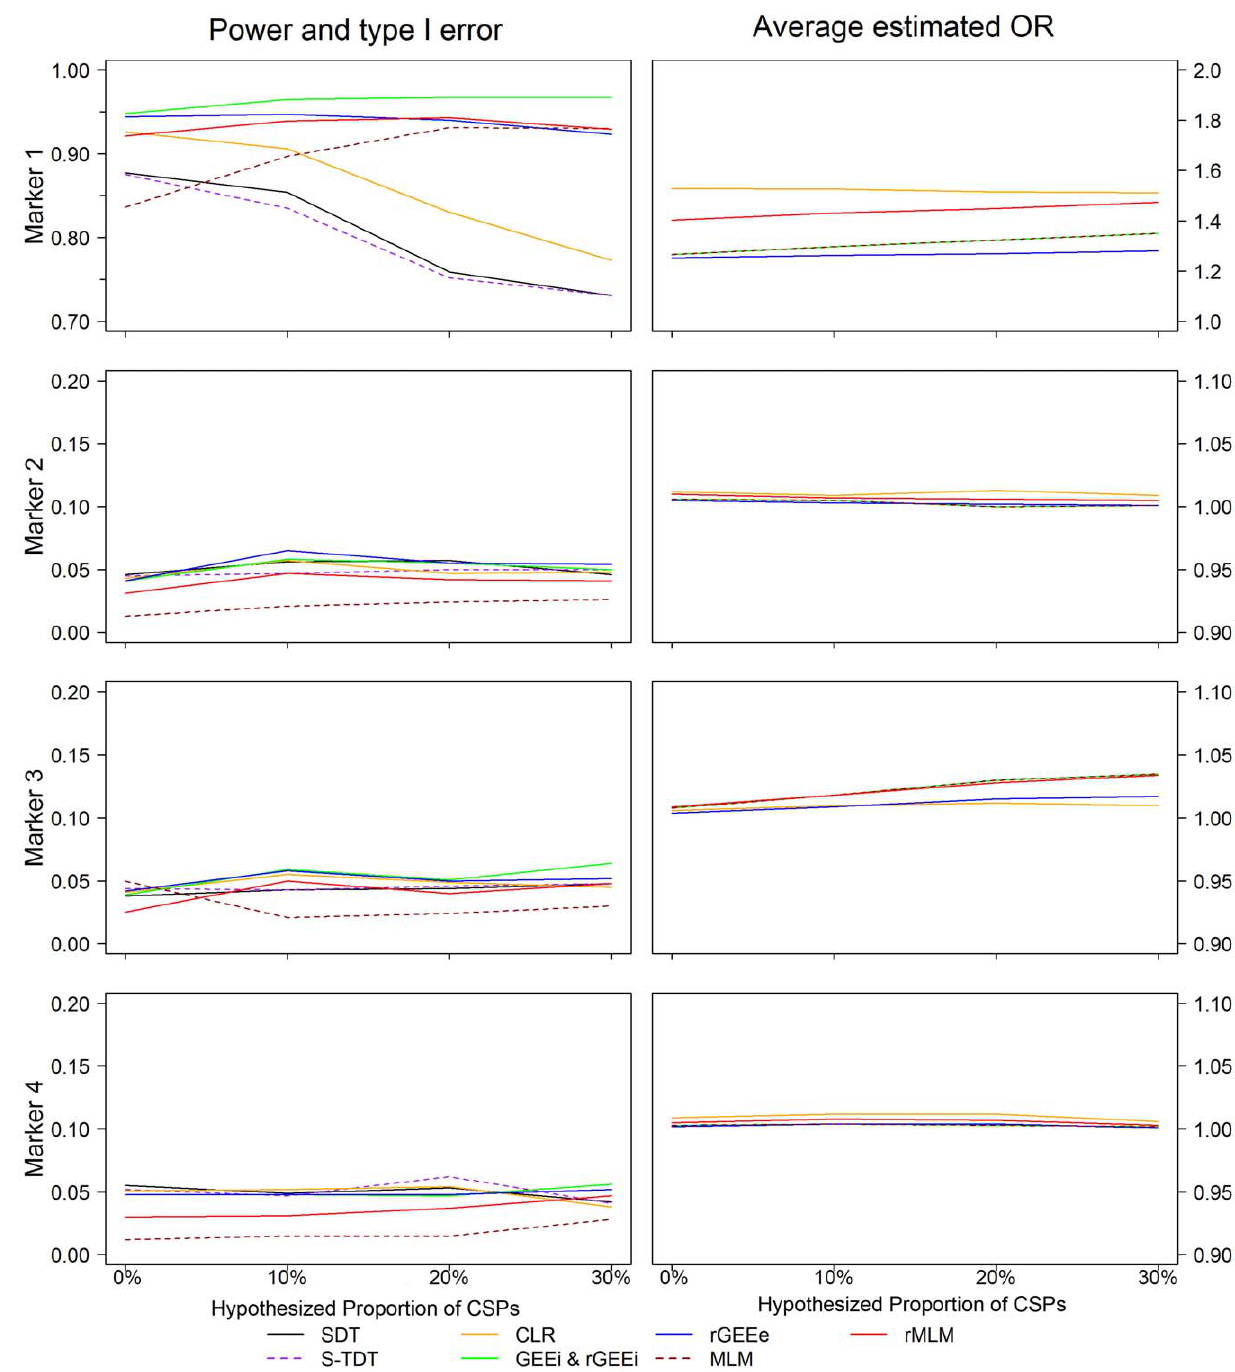
Figure 1. Measures of power (M1), type I error (M2) and parameter estimate of scenarios 1 to 4. The left panel of the figure shows the measures of power and type I error rate of rMLM, MLM, S-TDT, SDT, CLR, GEEi, rGEEi and rGEEe when there were different hypothesized proportions of CSPs in the data sets in scenarios 1 to 4 with GRR=1.5. The right panel shows the parameter estimates of rMLM, MLM, CLR, GEEi, rGEEi and rGEEe. In each plot, the x -axis denotes the hypothesized proportions of CSPs (one minus the hypothesized proportions of DSPs). As GEEi and rGEEi had the same results throughout our simulation, they are represented by the same color. GEEe is not shown due to its unstable results.